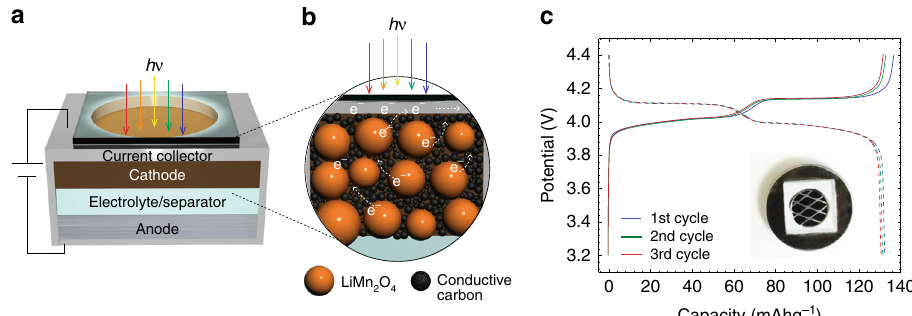
Fig. 1 The principle of a photo-accelerated lithium-ion battery cell. The cell consists of a transparent window, current collector, cathode, electrolyte, separator, and anode. The broadband white light is used with an IR fi lter to avoid undesired heating of the cell. b Magni fi ed view of the composite LMO cathode consisting of a Te fl on binder, (e.g. – (CF 2 ) n – ), carbon particles as conductive diluent (e.g. acetylene carbon black), and active oxide powder. c Galvanostatic cycling voltage pro fi le of a Li ││ 1.2 M LiPF 6 ; EC:EMC 3:7 (w:w) ││ LMO (EC = ethylene carbonate; EMC = ethyl methyl carbonate). Three cycles of charging (indicated in solid lines) and discharging (in dash lines) pro fi les between 3.2 and 4.4 V at a C/10 rate are shown. A photograph of a fabricated ‘ open ’ cell is shown in the